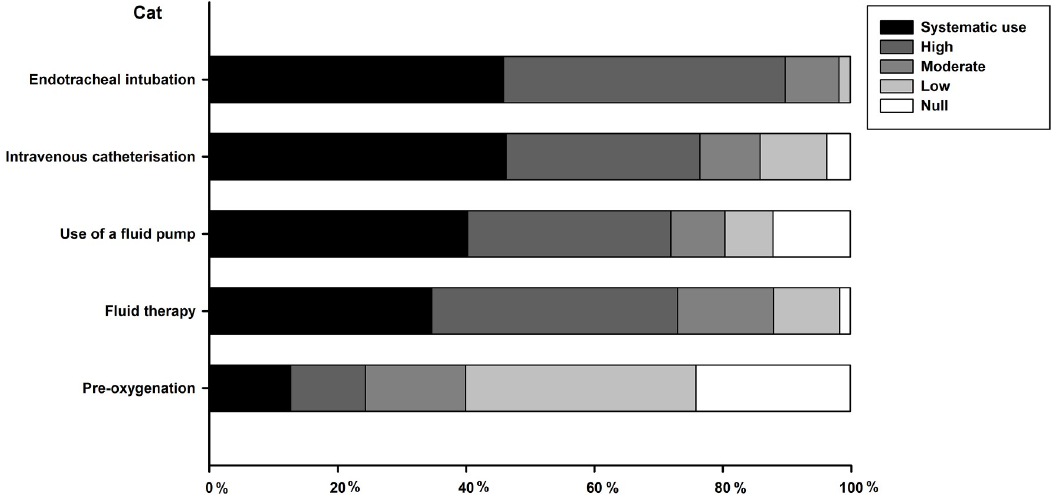
Fig 4. Cumulative percentage of respondents reporting their frequency of use for each technical procedure performed for cat anaesthesia. Frequency of use is color-coded, as systematic (or 100%), high (61 to 99%), moderate (21 to 60%), low (1 to 20%) or null (or